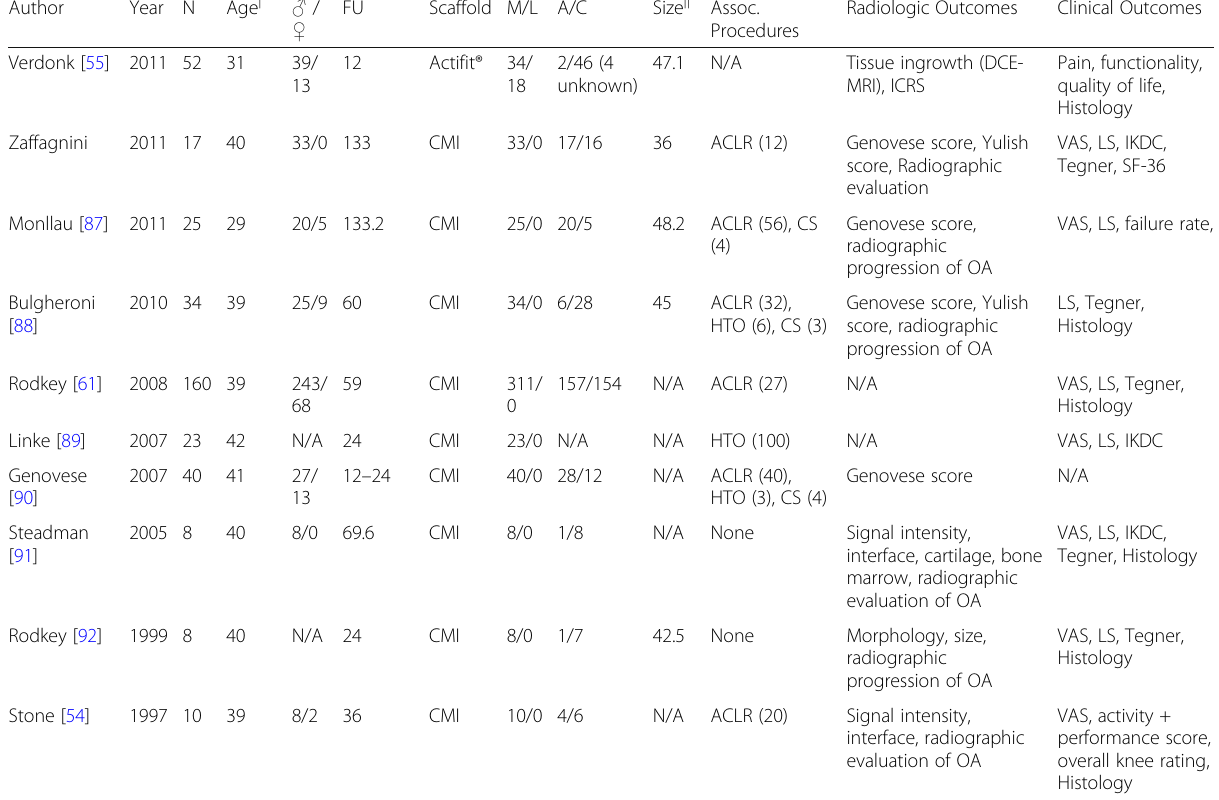
Table 1 Synopsis of clinical studies on scaffold-based meniscal substitutes (chronological order) (Continued) Author